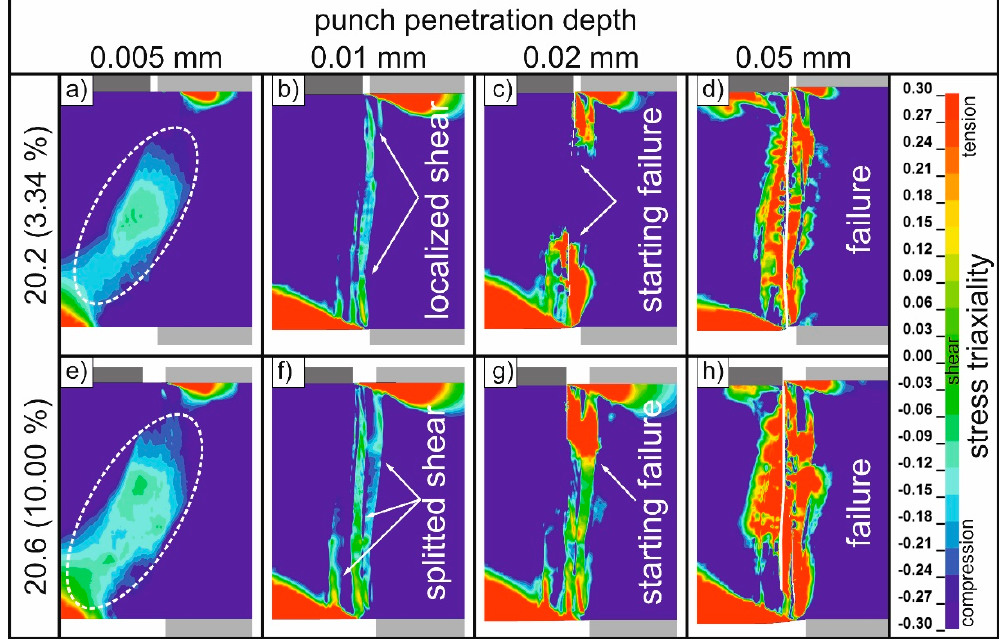
Figure 5. Results of the finite element simulation of the stress triaxiality in the shear zone with two blanking clearances (( a – d ) 20.2 and ( e – h ) 20.6) and different punch penetration depths.